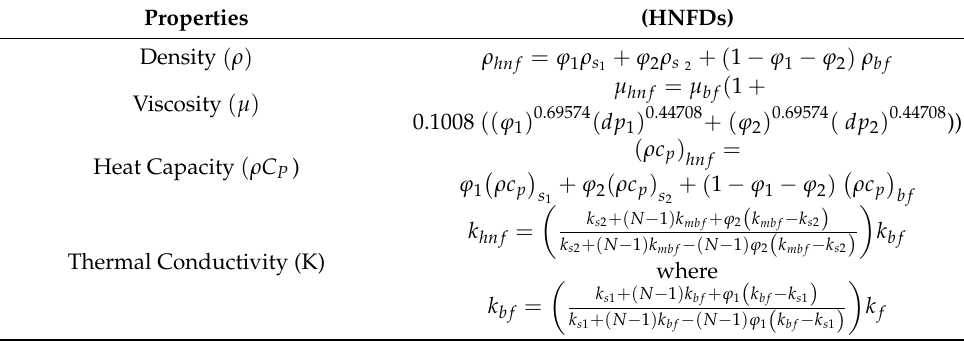
Table 1. Thermophysical properties of HNFDs [62–66].